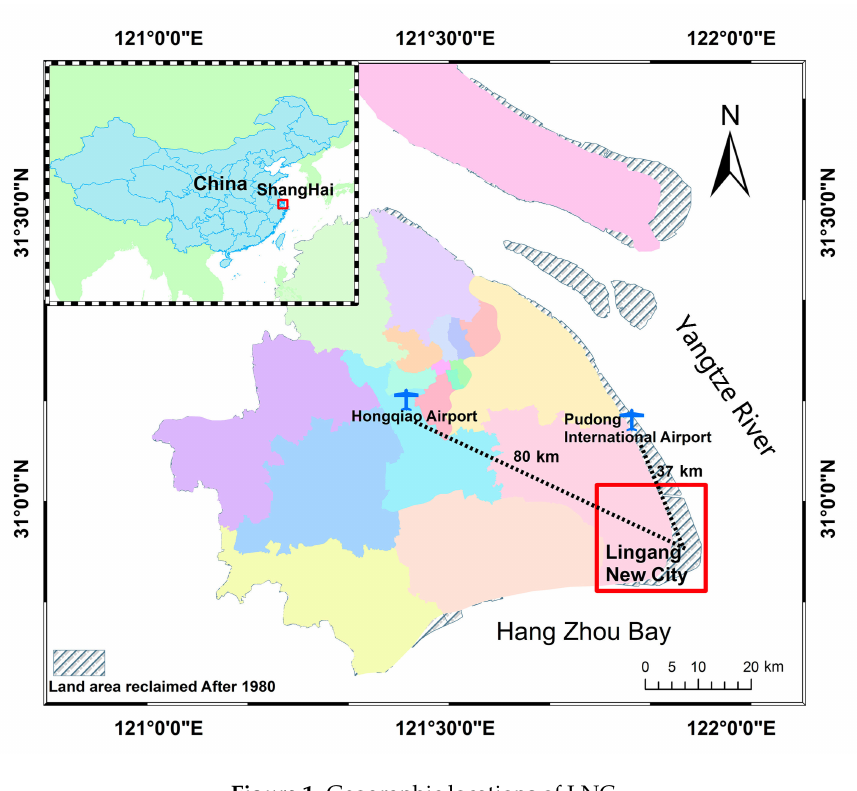
Figure 1. Geographic locations of LNC.